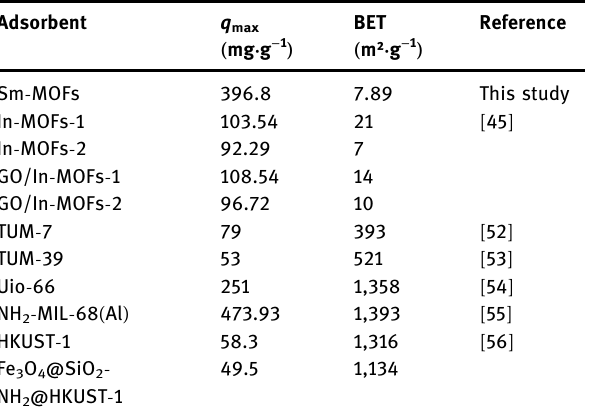
Table 1: Comparison of maximum adsorption capacities of various adsorbents for CR Adsorbent